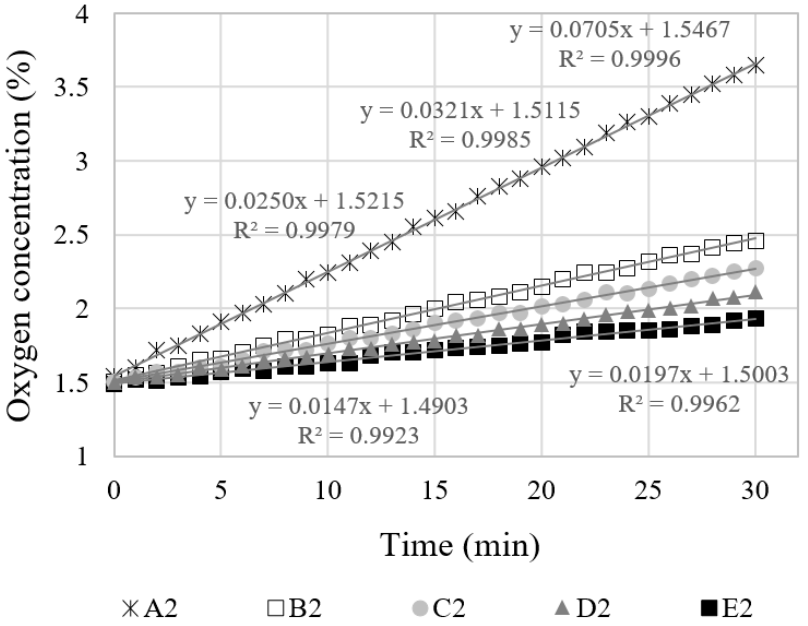
Figure 5. Oxygen concentration with respect to the thickness of specimens, crack width 0.2 mm.